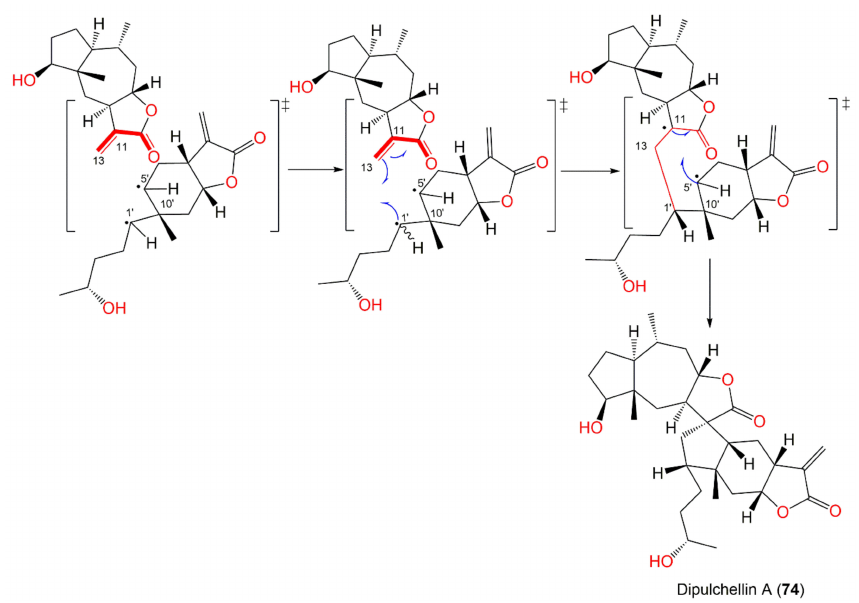
Scheme 8. Biosynthetic pathways of dipulchellin A ( 74 )